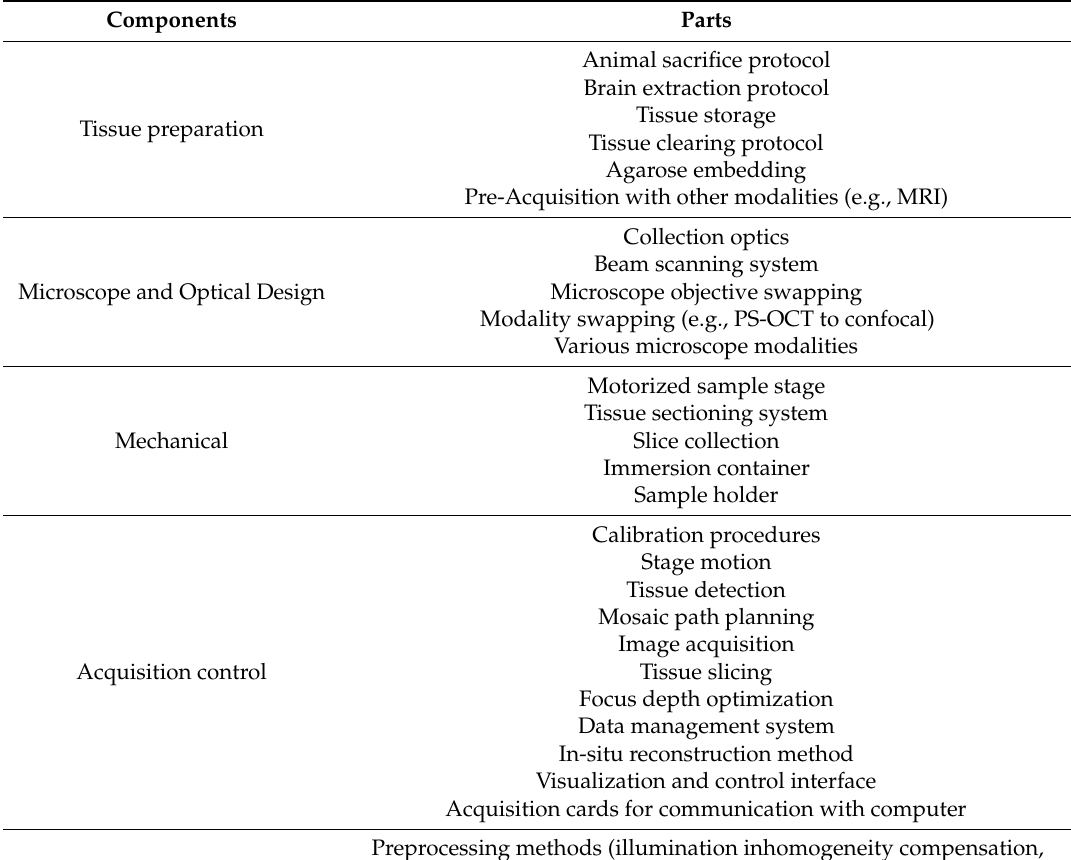
Table 2. The main components and parts of an SBH